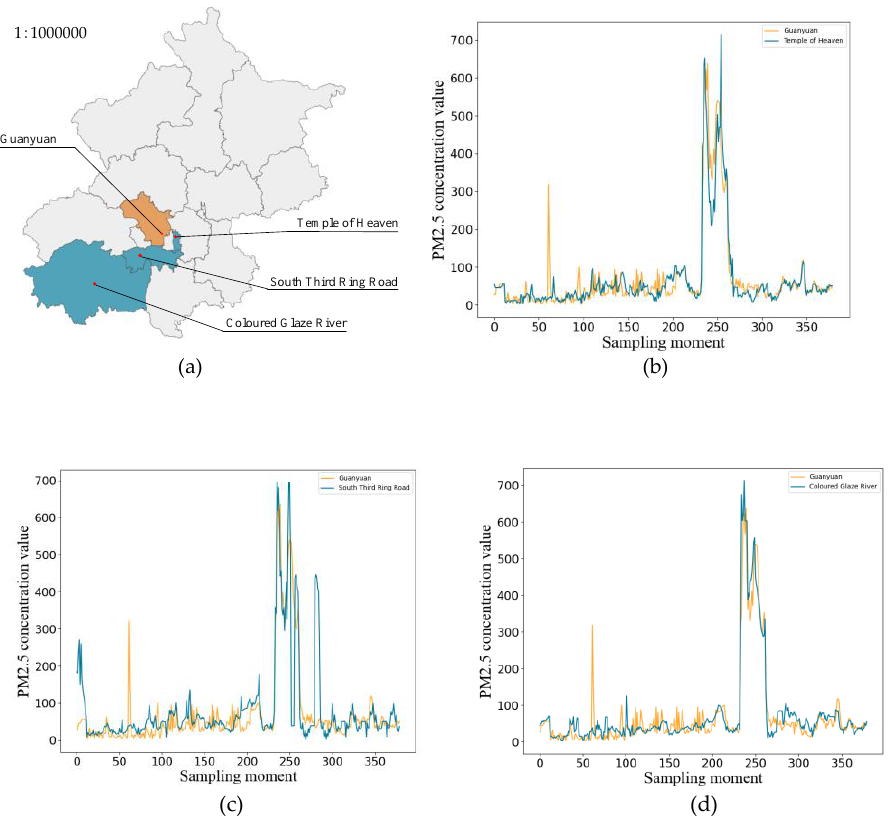
Figure 1. Spatial Correlation between different areas in Beijing. ( a ) the geographic location of four different areas in Beijing. The scale is 1:1,000,000. ( b ) PM2.5 changes in Guanyuan, Haidian, and Temple of Heaven, Dongcheng. ( c ) PM2.5 changes in Guanyuan, Haidian, and South Third Ring Road, Fengtai. ( d ) PM2.5 changes in Beijing Guanyuan and Coloured Glaze River, Fangshan.